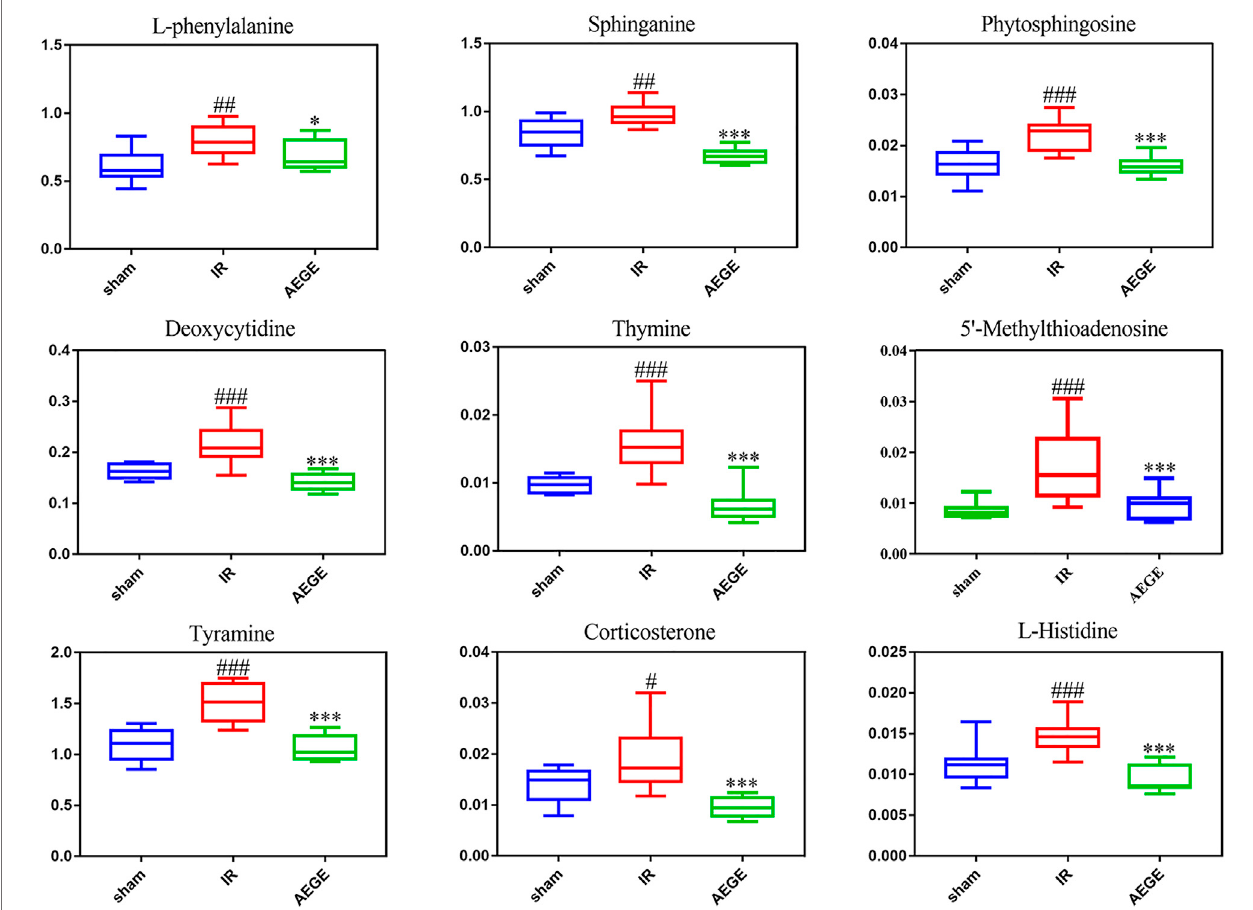
FIGURE3| Boxchartsoftherelativetrendsofmetabolitesinvolvedintheimportantmetabolicpathwaysthatwereidenti fi ed.Dataareexpressedasthemean ± SD. “ # ” represents sham group vs . the IR group (# p < 0.05, ## p < 0.01, ### p < 0.001); “ * ” represents IR group vs . the AEGE group (* p < 0.05, *** p < 0.001).